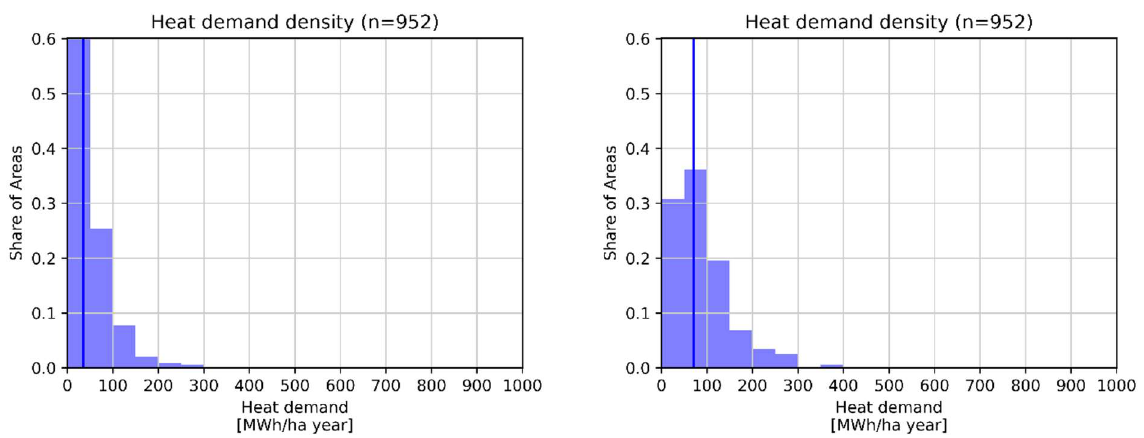
Figure 8. Frequency of grid cells according to their heat demand density in Waidhofen weighted based on the number of areas ( left ) or the total floor area of the respective area ( right ). The vertical line indicates the median value.